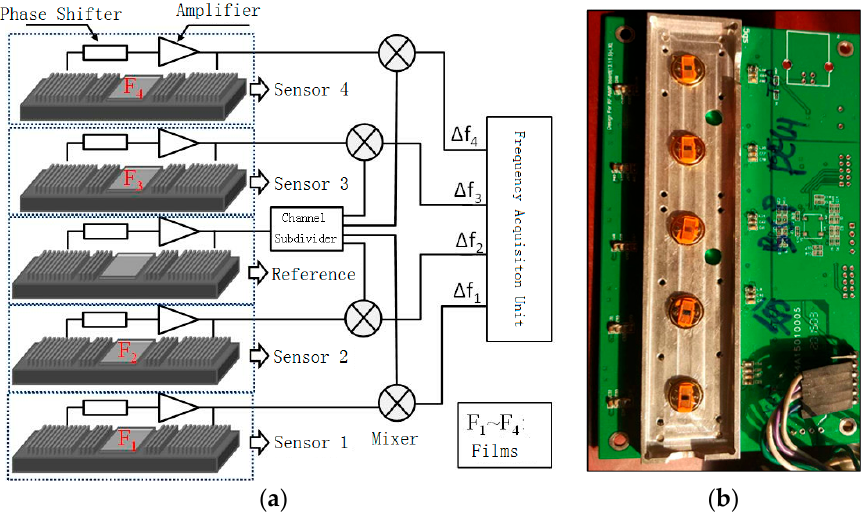
Figure 1. ( a ) Schematic of the SAW sensor array (sensor 1, coated with TEA; sensor 2, coated with PECH, sensor 3, coated with SXFA, sensor 4, coated with GAH); ( b ) The photo of the SAW sensor array.